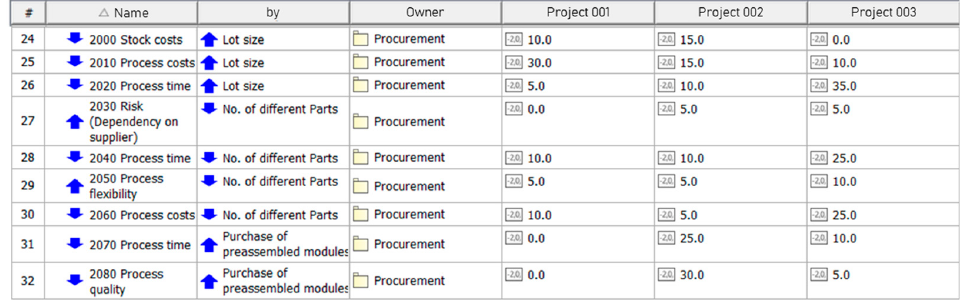
Figure 9. Generic table and data collection in Sys-IMF for three analyzed modularization projects for the life phase of procurement.